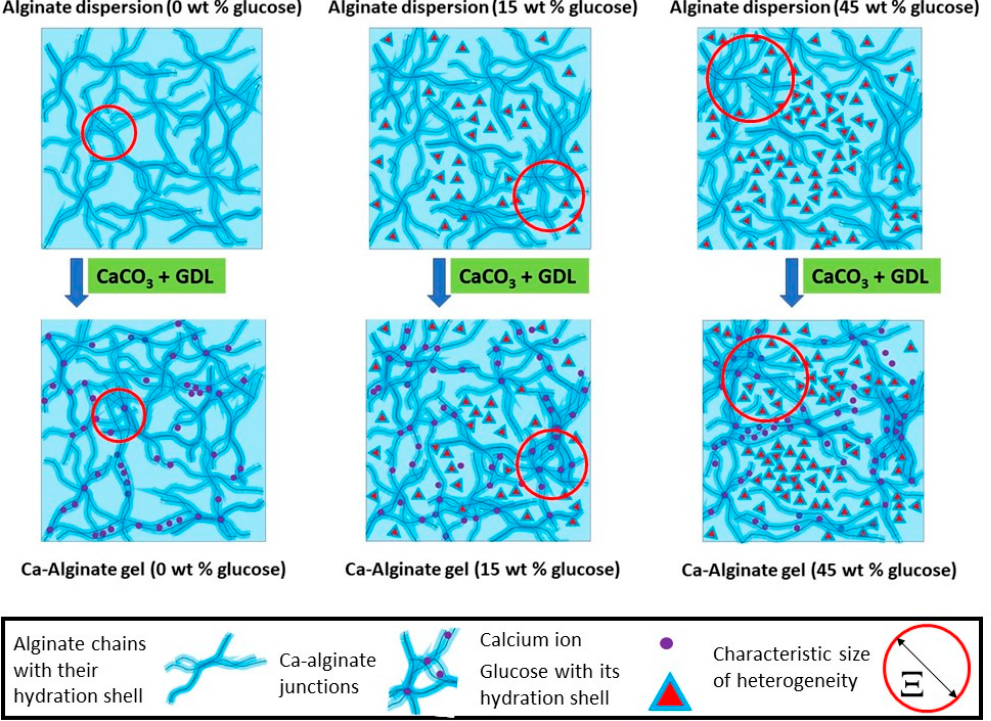
Figure 4. Schematic representation of the structure of the alginate solutions and calcium-alginate gels with different glucose concentrations.